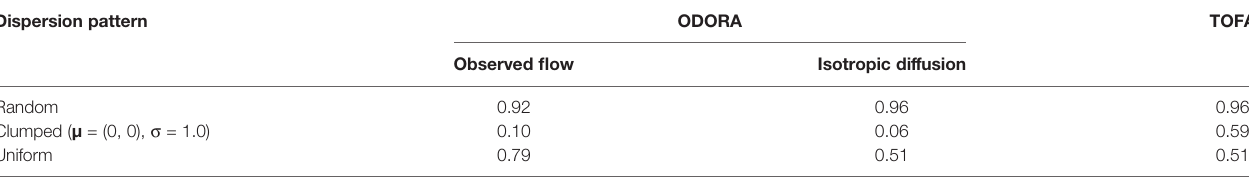
TABLE 2 | Expected value of estimated area rescaled by the equivalent area r -1 (nondimensional